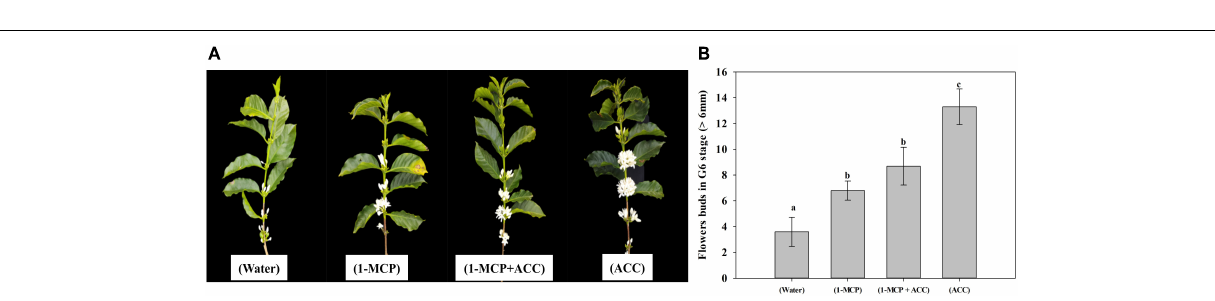
FIGURE 4 | Phytohormones contents. (A) ACC, (B) Ethylene, (C) ACO, and (D) ABA quantification in leaves, flower buds, and roots in the field experiment II (covered and uncovered plants of Paraiso 2 coffee cultivar). Data are means ± 95% SD of the mean ( n = 6). Different upper-case and lower-case letters indicate statistical differences of each tissue among the different treatments and the different tissues within the same treatment, respectively.